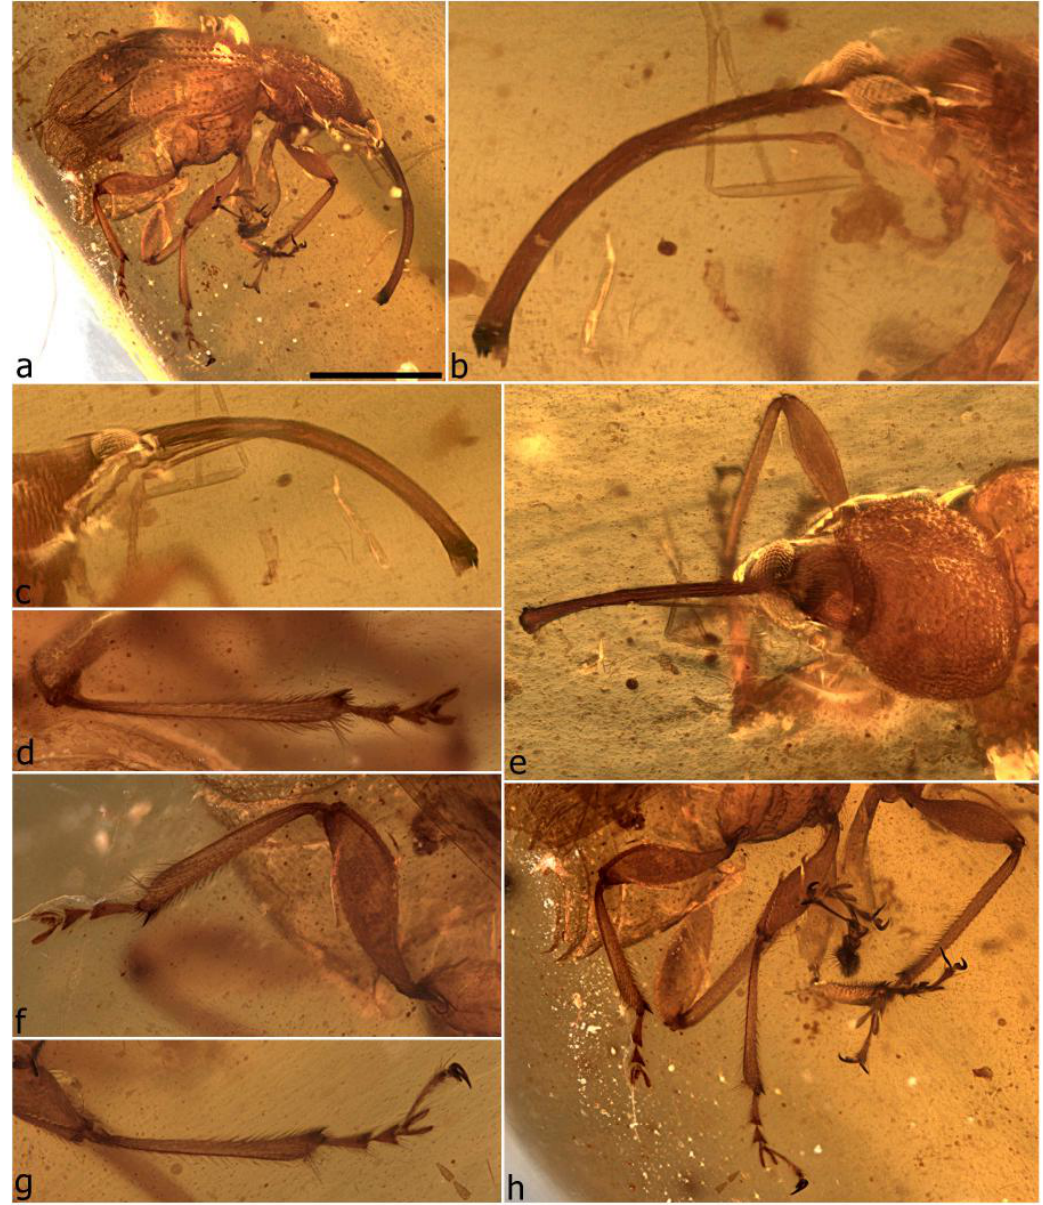
Figure 80. Leptopezus rastellipes sp. n., holotype. Habitus, right lateral ( a ); head and antenna, left lateral ( b ); same, right lateral ( c ); right metatibia and tarsus ( d ); head and pronotum, dorsal ( e ); right hindleg, outer side ( f ); right middle leg ( g ); legs ( h ). Scale bars: 1.0 mm (a). Leptopezus barbatus Clarke & Oberprieler, sp. n. (Figure 81) Description. Size. Length 2.12 mm, width 1.15 mm. Eyes slightly protruding, slanting backwards, forehead triangular. Rostrum slightly longer than pronotum, downcurved, thick at base, gradually narrowing and widening distad; antennal insertions in middle of rostral length, in front of them with lateral row of 7–8 long, erect setae curved anteriad. Antennae. Scapes straight, narrowly cylindrical, apically strongly clavate, reaching below eye; funicles not clearly visible; clubs long, segment l longer than 2, 1 and 2 widening apicad, 4 as long and broad as 3, flattened. Mouthparts. Mandibles not clearly discernible. Thorax . Pronotum elongate, laterally weakly curved; convex, densely setose, setae pale, long directed anteromesad, sculpture not discernible. Scutellar shield small, transverse, slightly rounded. Meso- and metaventrite distorted. Elytra short, broad, at base slightly sinuate, closely fitting onto prothorax, with broadly rounded, flattened humeri, posteriorly